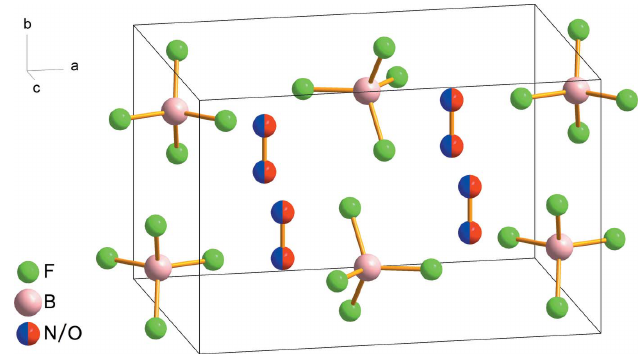
Figure 2 View of the packing in the unit cell of the NOBF 4 crystal structure.